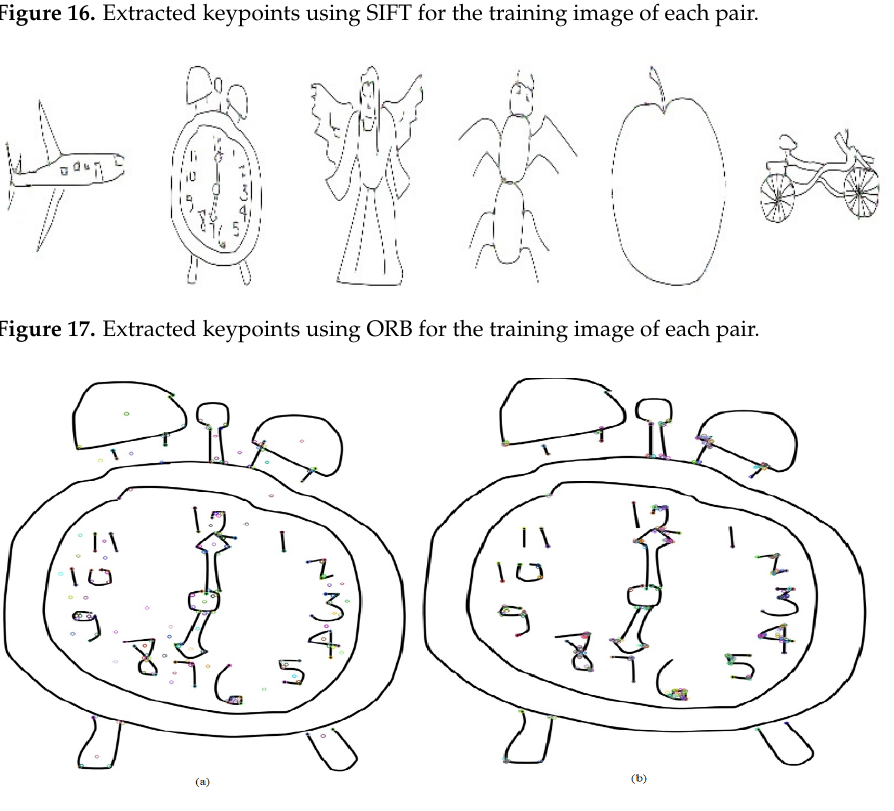
Figure 18. Extracted keypoints using ( a ) SIFT and ( b ) ORB.